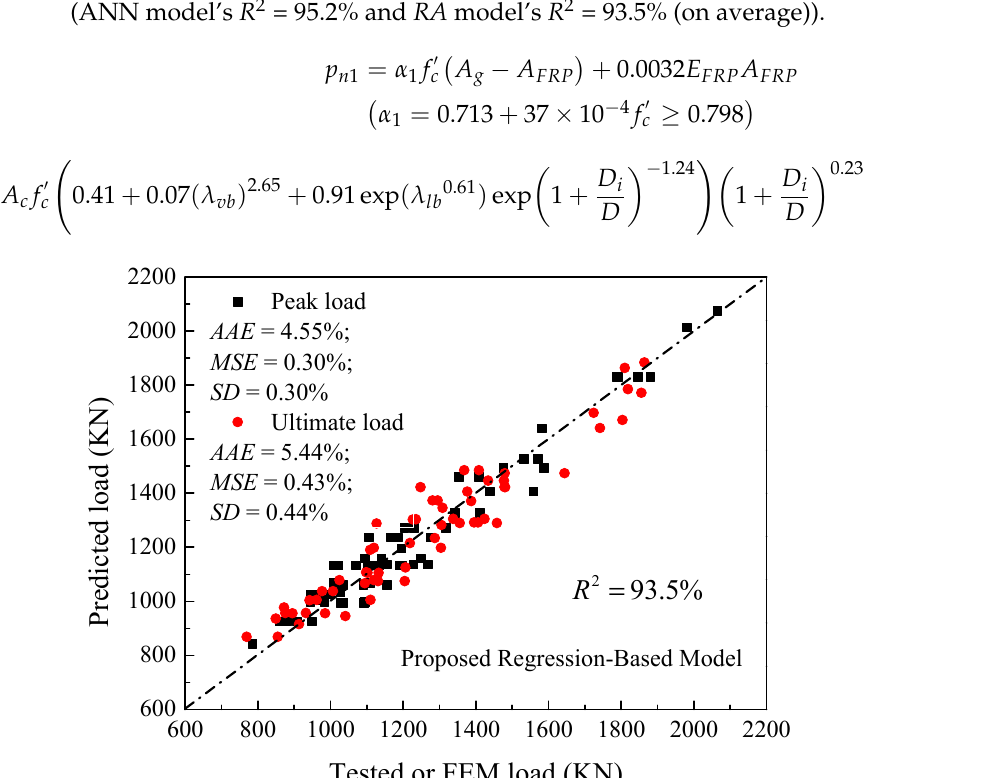
Figure 19. Performance of the proposed analytical model of HCCs. After predicting the stress-strain relationship of HCCs by Equations (33) and (34), the load-strain curve can be generated. To evaluate the proposed model in terms of